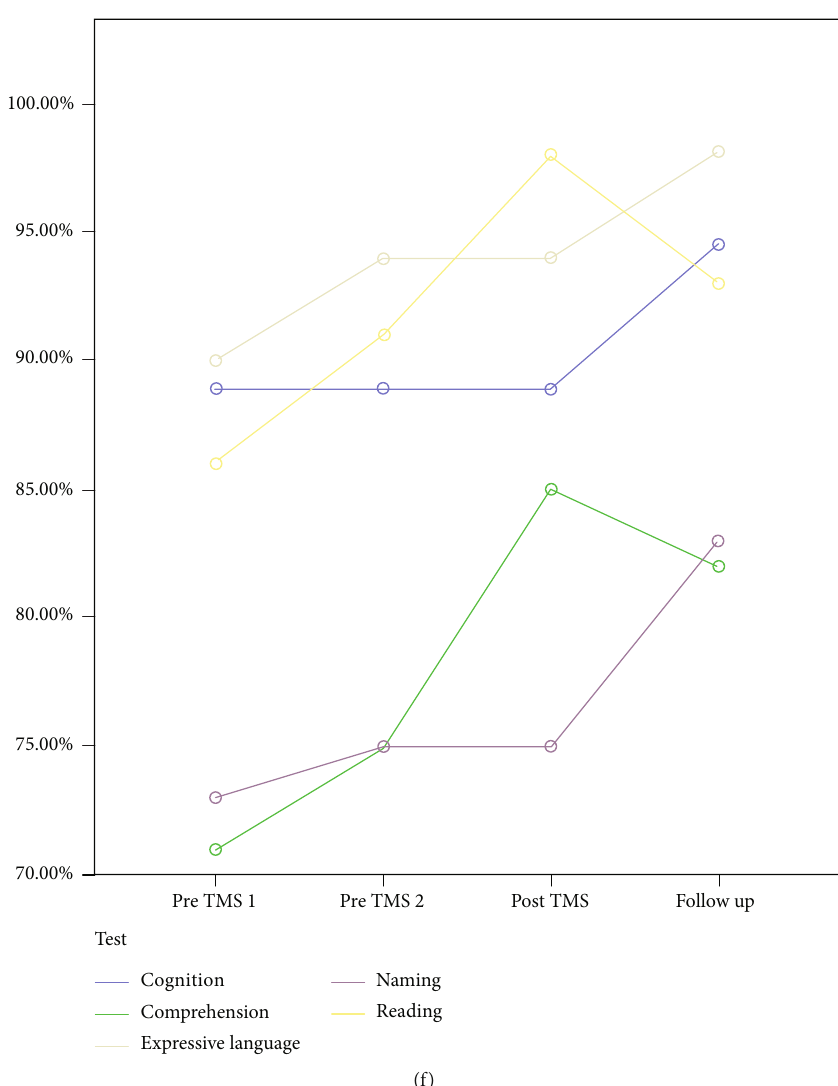
Figure 3: Short-term (one day posttreatment) and long-term (two months, one year, and two years posttreatment) e ff ects of cTBS on cognitive and language performance for all 6 participants. The Y axis depicts relative values to demonstrate the magnitude of variation, if any, between assessments for each domain. Key: pre-TMS 1: baseline 1; pre-TMS 2: baseline 2; post-TMS: 1 day posttreatment; follow-up 1: 2 months posttreatment; follow-up 2: 1 year posttreatment; follow-up 3: 2 years posttreatment; follow-up: 2 months